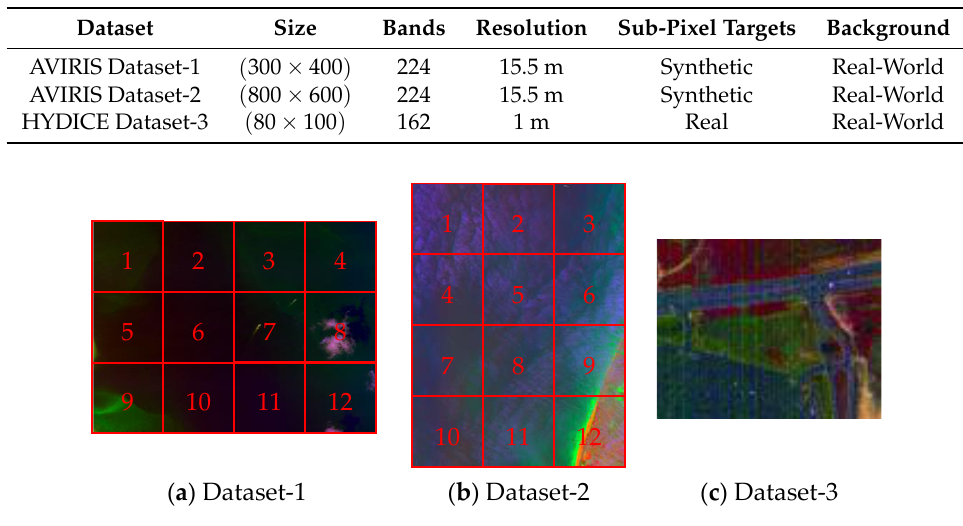
Figure 4. False color image of each dataset. Figure 5. False color image of each